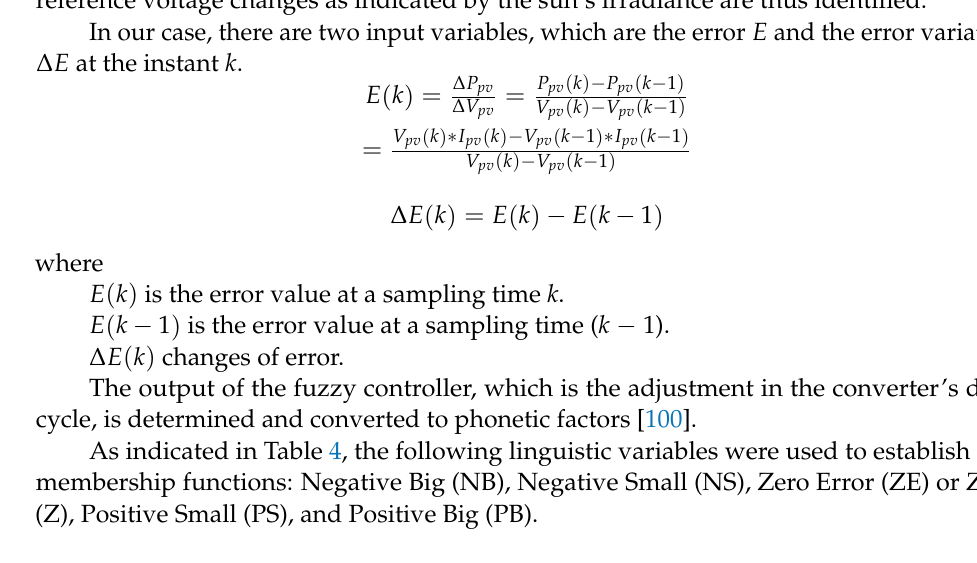
Table 4. Fuzzy logic rule